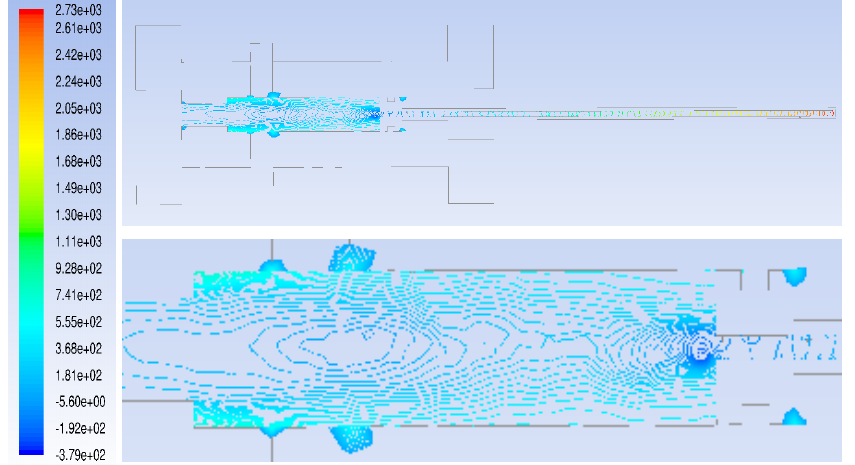
Figure 11. Pressure distribution